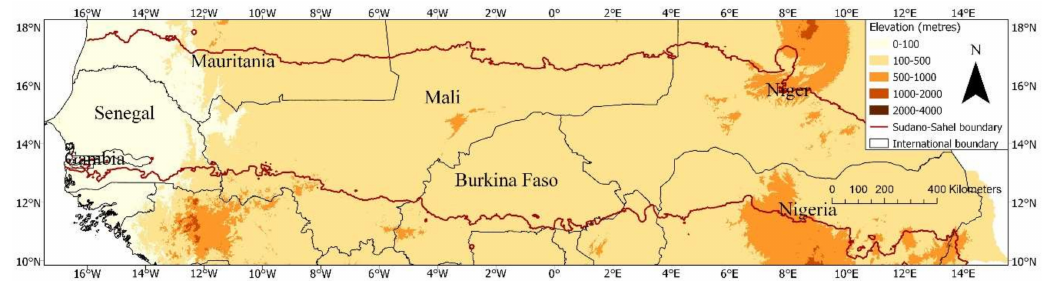
Figure 1. Map of the West African Sudano-Sahelian (WASS)